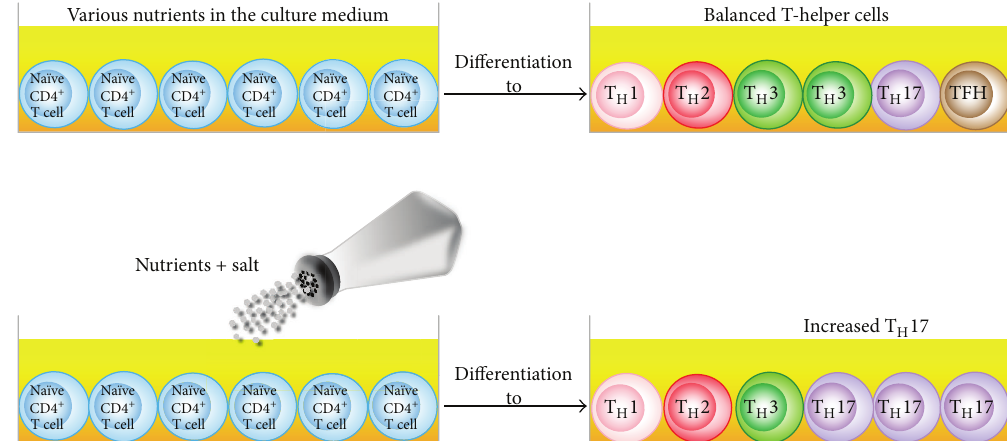
Figure 10: Salt affects the differentiation of na¨ıve CD4 + cells. Increased concentrations of salt resulted in the differentiation of na¨ıve CD4 + T cells into a greater number of T H 17 cells.